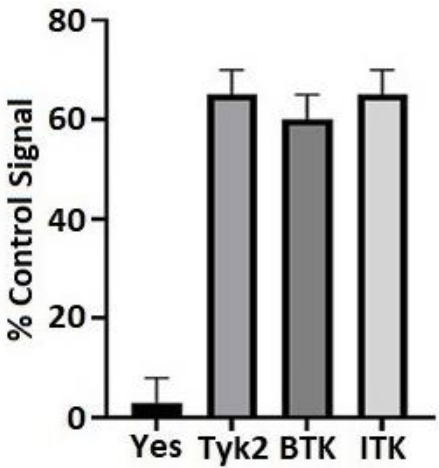
Figure 1. Identifying novel kinases that phosphorylate Cx43. In vitro kinase screening was performed using purified Cx43CT and the catalytic domains of BTK and ITK. A positive control peptide was used for each kinase (100% signal) to calculate the Cx43CT phosphorylation signal. The Src and Jak family members Yes and Tyk2 were shown to illustrate negative and positive results from the screen, respectively.